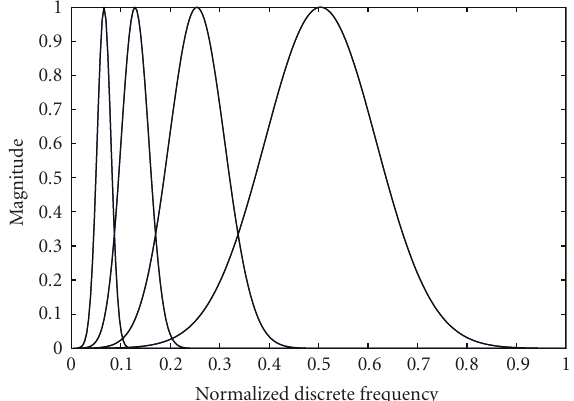
Figure 2: Frequency response of 1-dimensional Gabor wavelets ( f = [0.5, 0.25, 0.125, 0.0625] and η = 1).